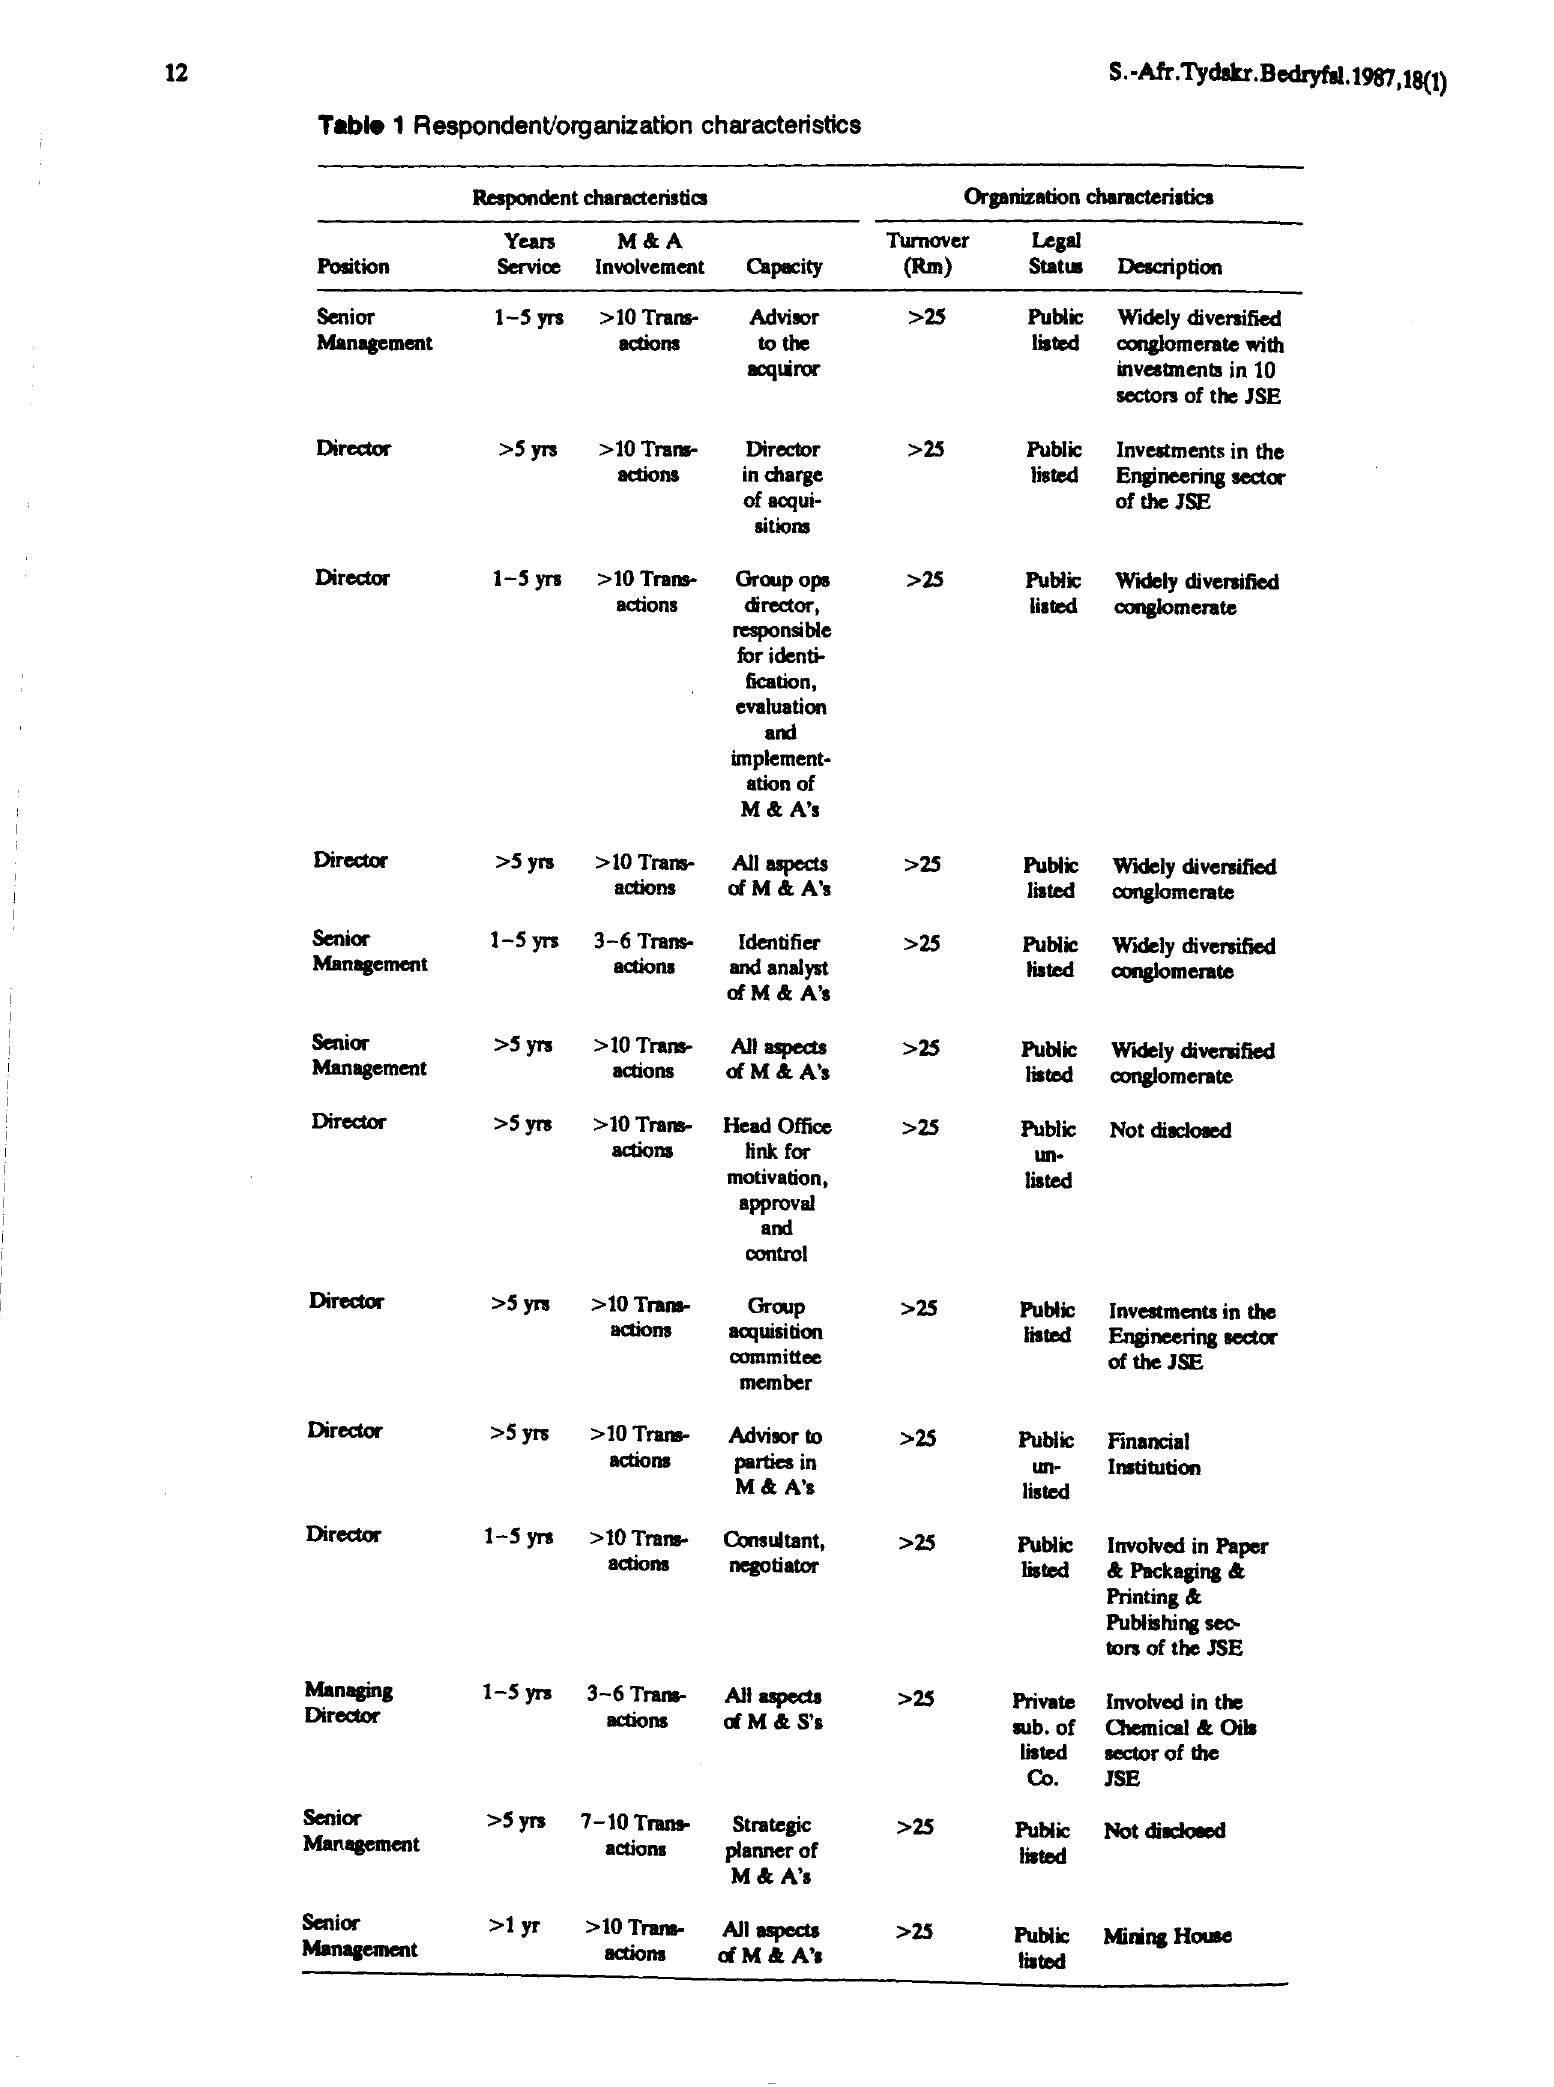
Table 1 Respondent/organization